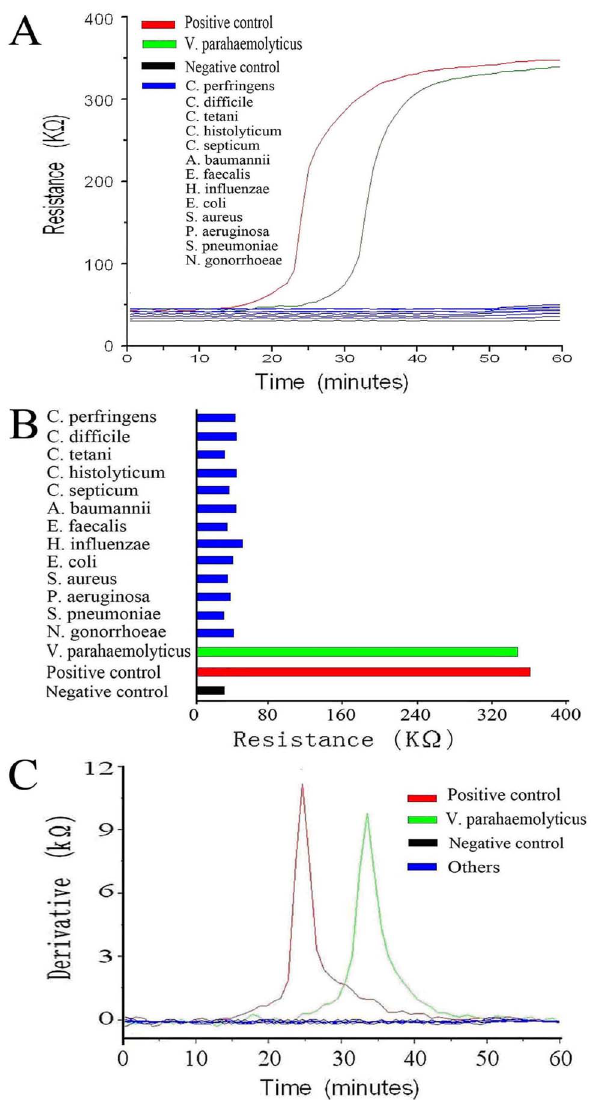
Figure 2. Specificity analysis of the real-time resistance measurement. A. The real-time resistance curve of V. parahaemoly- ticus and other interfering bacteria. B. End-point resistance of V. parahaemolyticus and other interfering bacteria after a 60-min LAMP assay. C. Derivative analysis of the real-time resistance measurement.